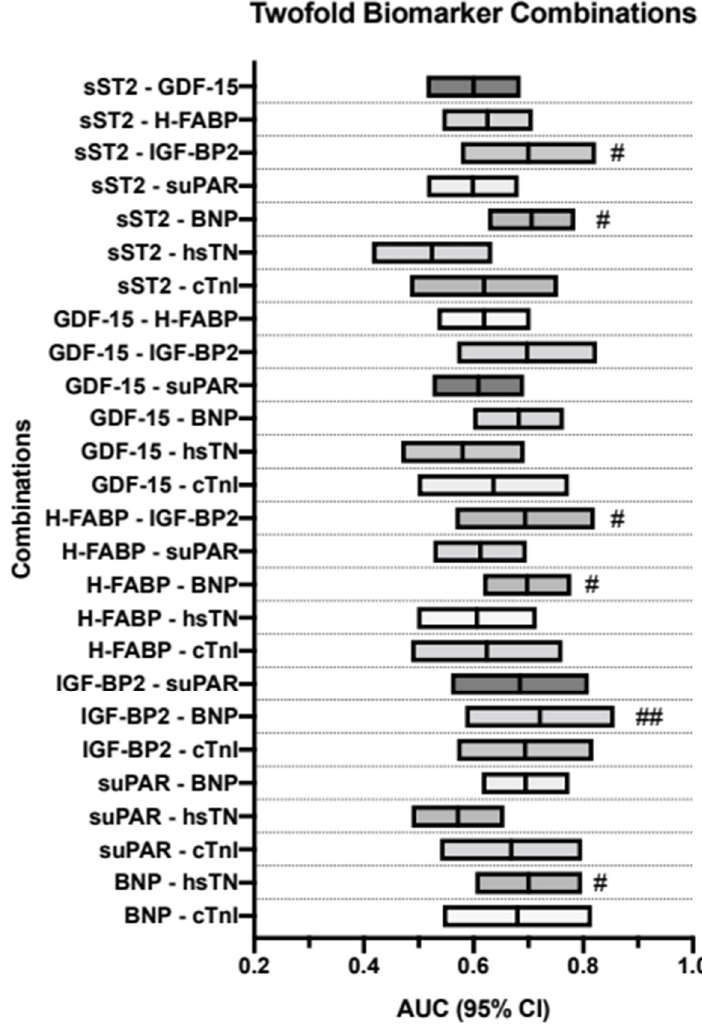
Figure 5. Two-way biomarker combinations with corresponding AUROC analyses and diagnostic